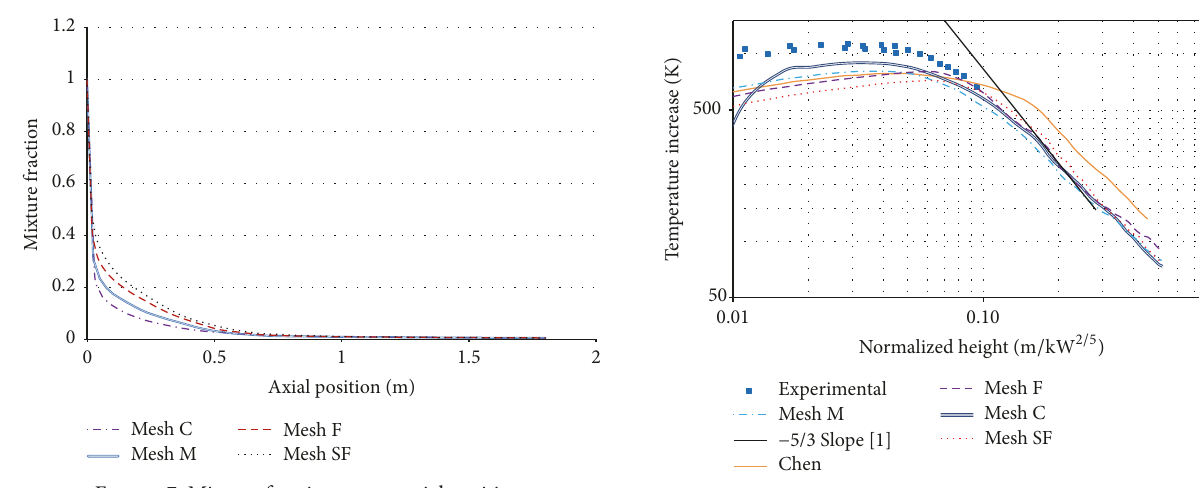
Figure 7: Mixture fraction versus axial position.